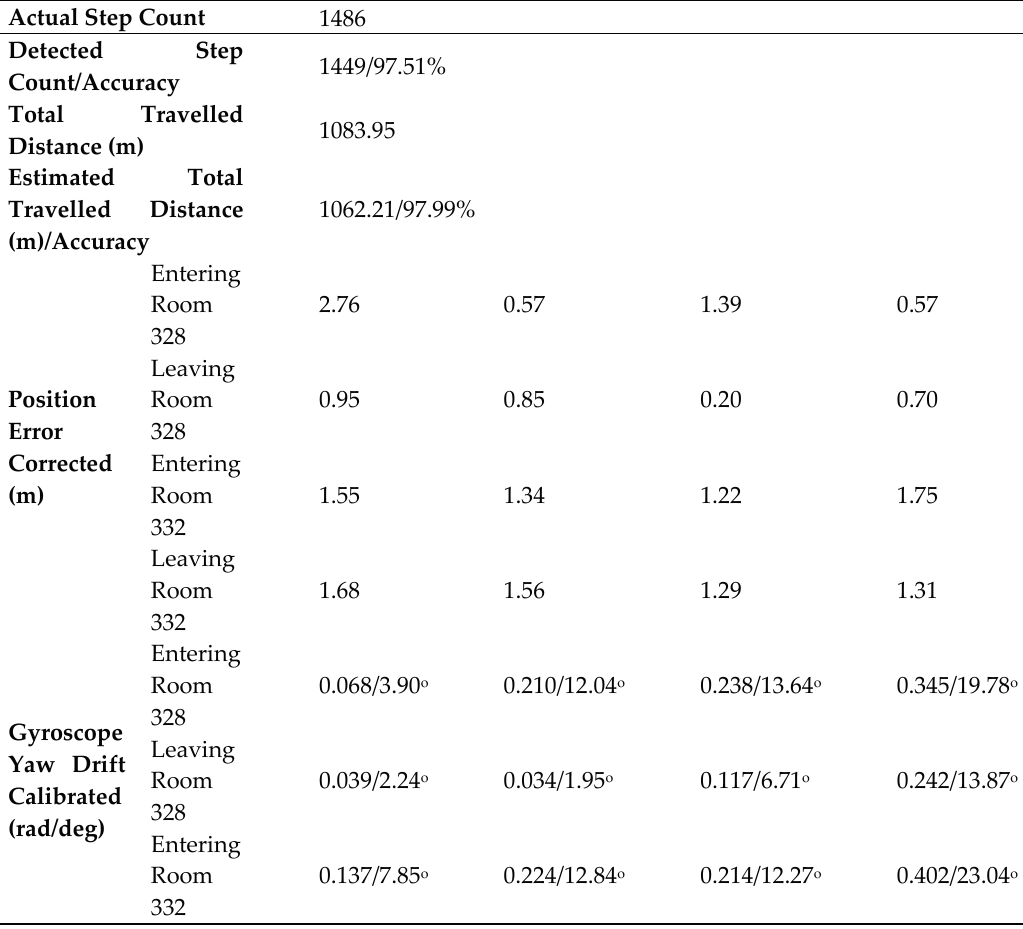
Table 3. Tracking performance of the long-term